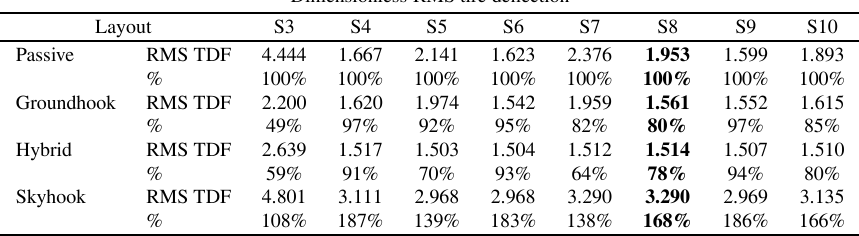
Table 5 Dimensionless RMS tire de fl ection